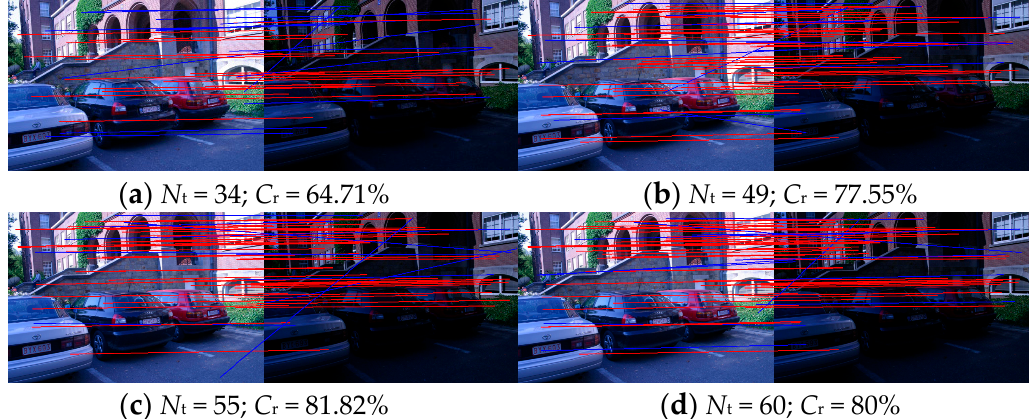
Figure 6. Results of ( a ) W α SH, ( b ) WWF, ( c ) IWWF, and ( d ) LIWWF for the 5th image pair of Leuven. The red lines indicate correct matches while the blue lines are incorrect matches.